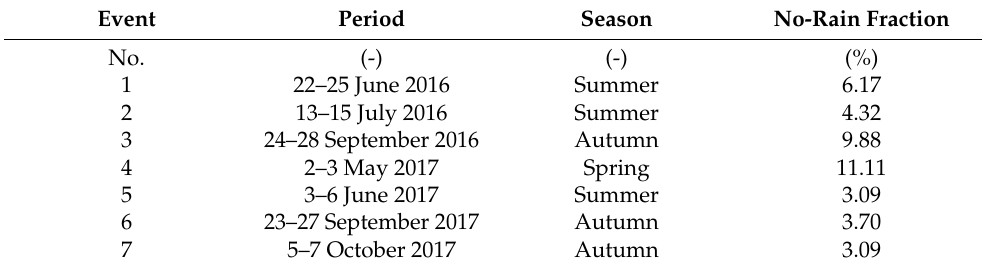
Table 3. Information of selected rainfall